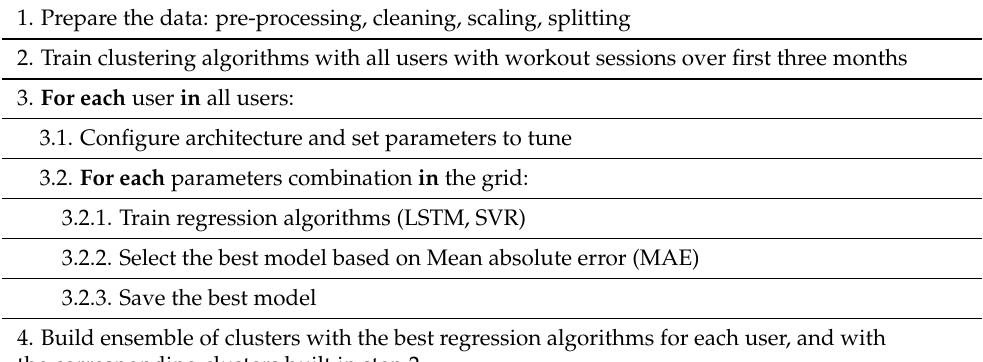
Table 5. Proposed framework algorithm: training.